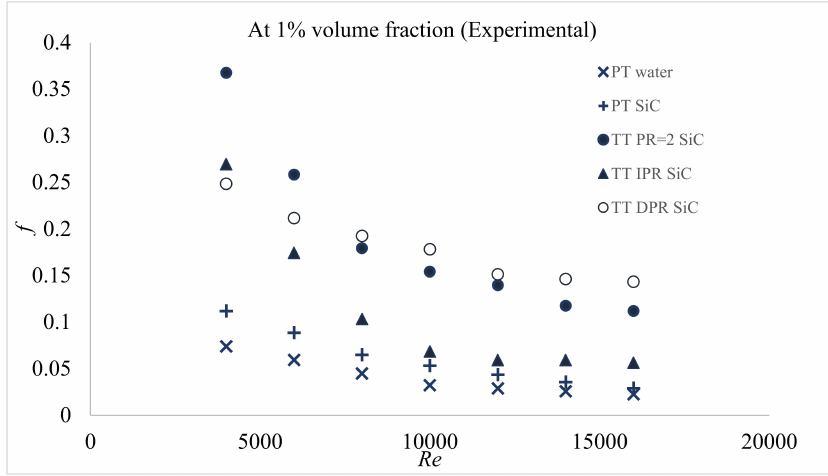
Figure 19. E ff ect of the type of inserts on f (Experimental).